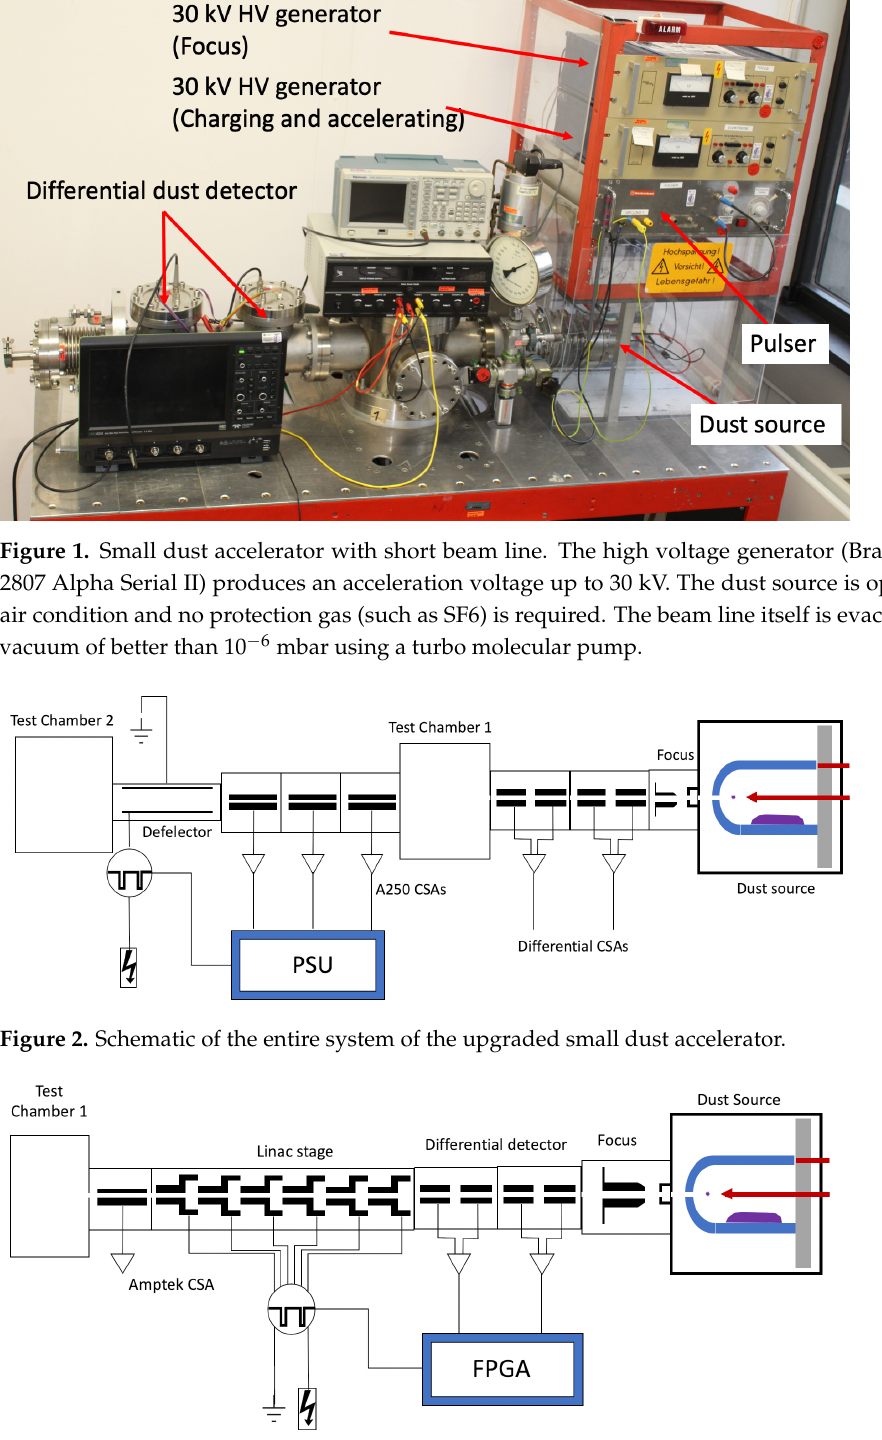
Figure 3. Schematic diagram of the entire accelerator with post-stage linac.